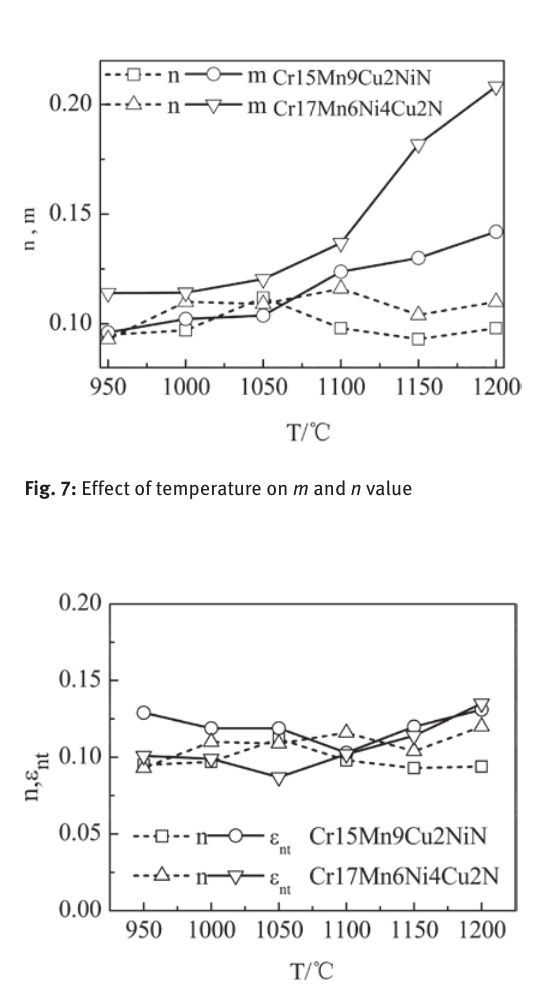
Fig. 8: The n value and necking true strains